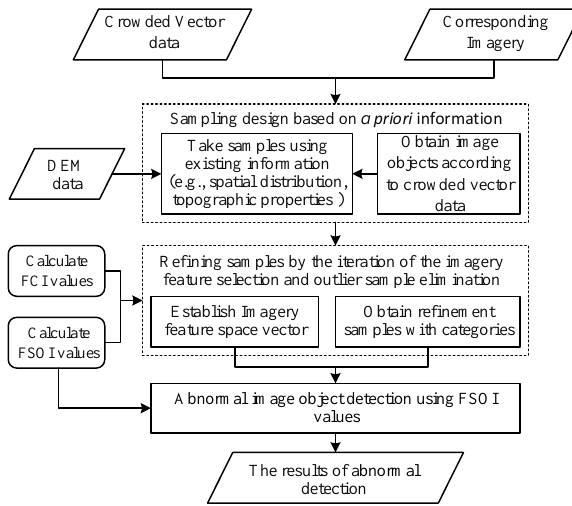
algorithm. The proposed abnormal crowdsourcing data detection framework is shown in Figure 1.